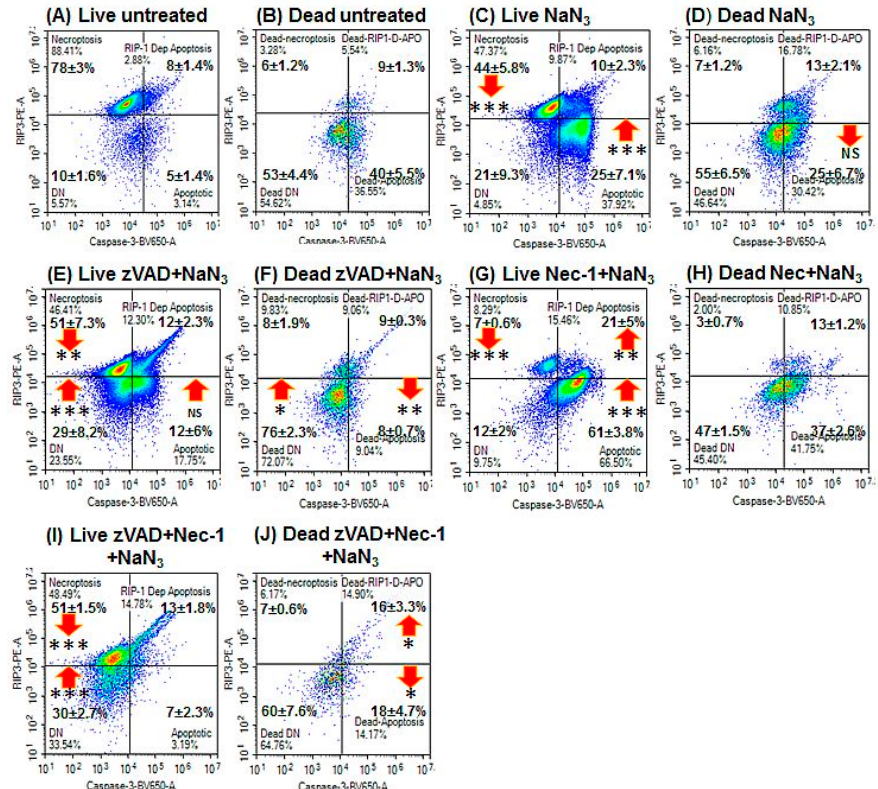
Figure 2. RIP3 and caspase-3 activation analysis of oncosis. After gating on live and dead cells from a Zombie NIR vs. caspase3-BV650 dot-plot ( A ) untreated live and ( B ) dead Jurkat cells were analysed on a RIP3-PE vs. caspase-3-BV650 dot-plot with resting phenotype indicated by RIP3 + ve / caspase-3 –ve , apoptosis by RIP3 –ve / caspase-3 + ve , RIP1-dependent apoptosis RIP3 + ve / caspase-3 + ve , and double negative RIP3 –ve / caspase-3 –ve . Live and dead cells treated with ( C,D ) 0.25% NaN 3 for 24 h; ( E , F ) pre-treated with 20 µ M zVAD for 2 h, then treated with 0.25% NaN 3 ; ( G , H )pre-treated with 60 µ M Nec-1 for 2 h, then treated with 0.25% NaN 3 ; and ( I , J ) pre-treated with 20 µ M zVAD and 60 µ M Nec-1 for 2 h, then treated with 0.25% NaN 3 , respectively. n = 3, % Mean ± % SEM, Student’s t –test: NS (not significant), * p < 0.05, ** p < 0.01**, *** p < 0.001; arrows indicate change compared with untreated cells.